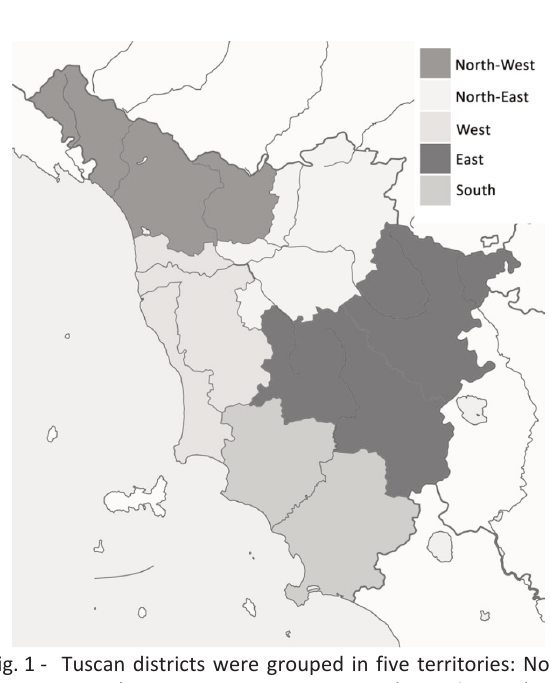
Fig. 1 - Tuscan districts were grouped in five territories: North- West (Massa-Carrara, Lucca, Pistoia), North-East (Prato, Firenze), West (Livorno, Pisa), East (Arezzo, Siena), South